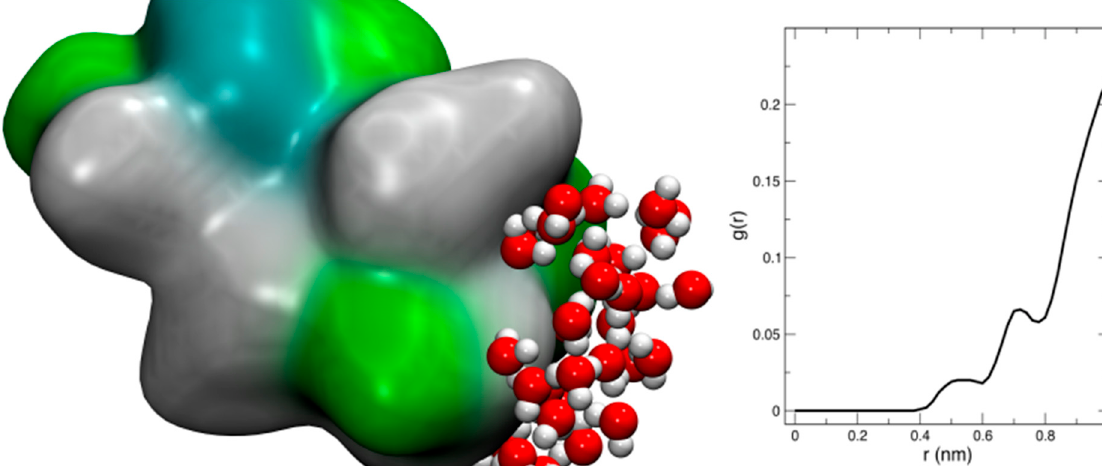
Figure 4. Left panel: Surface representation of the protein residues at the entrance of the binding cavity. The surface is colored according to the hydrophobicity and charge of the amino acids. Surface regions covering neutral hydrophobic and hydrophilic amino acids are depicted in grey and green, respectively, while those covering charged amino acids are colored in blue. The protein orientation is similar to that of Figure 3. Right panel: Radial distribution function of water oxygens around the phenolic oxygen of pCA.